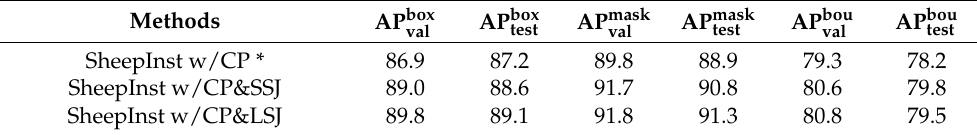
Table 2. Comparison with different data augmentation on validation set and test set.